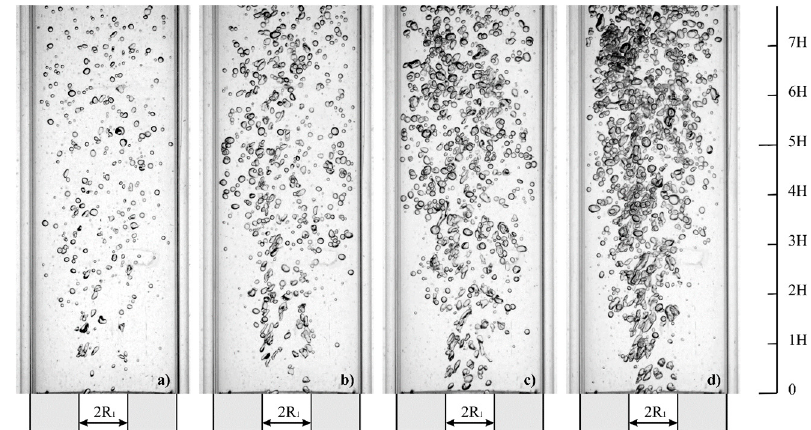
Figure 2. The photographs of bubbles in the sudden pipe expansion two-phase flow. Re H = 2.09 × 10 4 , 2 R 1 = 15 mm, H = 13.5 mm, 2 R 2 = 42 mm, ER = ( R 2 / R 1 ) 2 = 7.84. ( a )— β = 0.6%, ( b )—1.8, ( c )—3.5; ( d )—5.2.